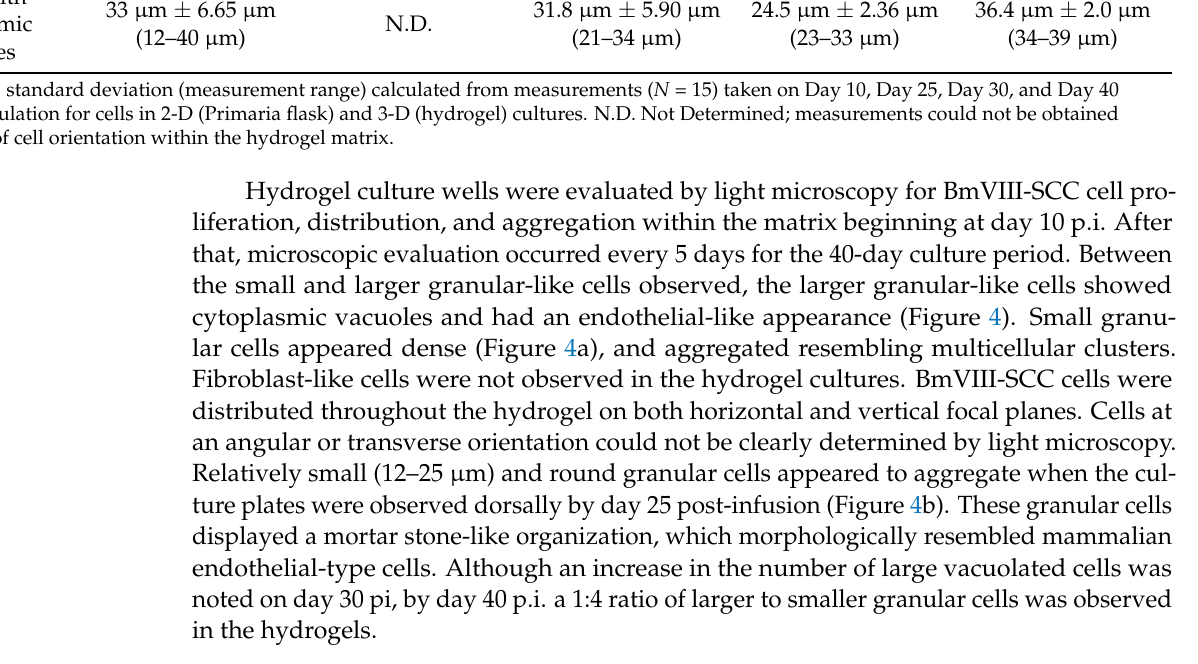
* Mean ± standard deviation (measurement range) calculated from measurements ( N = 15) taken on Day 10, Day 25, Day 30, and Day 40 post-inoculation for cells in 2-D (Primaria flask) and 3-D (hydrogel) cultures. N.D. Not Determined; measurements could not be obtained because of cell orientation within the hydrogel matrix.